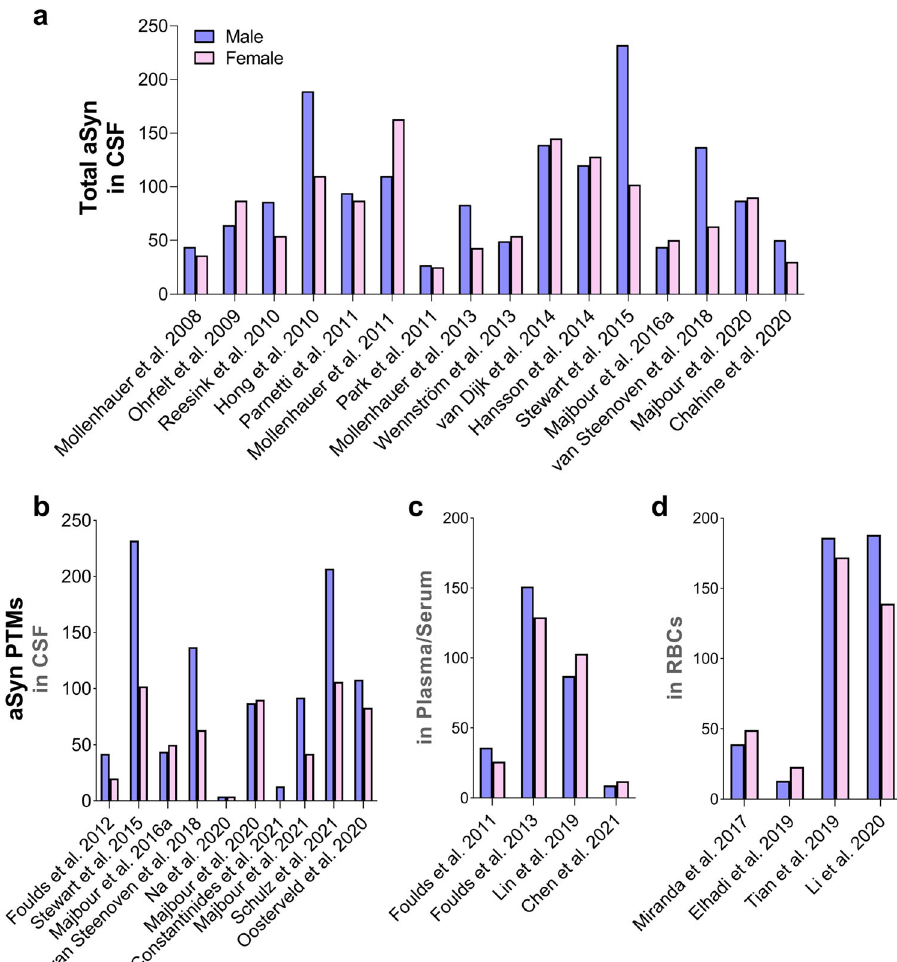
Fig. 8 Gender representation across the different aSyn-biomarker studies. Male vs. female representation in studies that aimed to measure the levels of a total aSyn in CSF and aSyn PTMs in b CSF, c plasma/serum and d